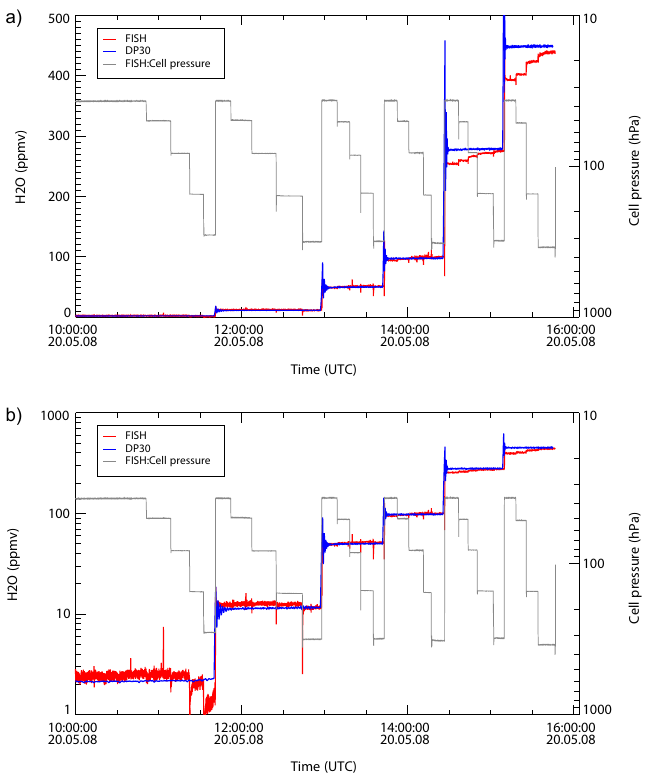
Figure 4. FISH and DP30 WVMR time series measured with the Jülich calibration bench with a flow rate of 5standard Lmin − 1 : (a) linear scale; (b) logarithmic scale.